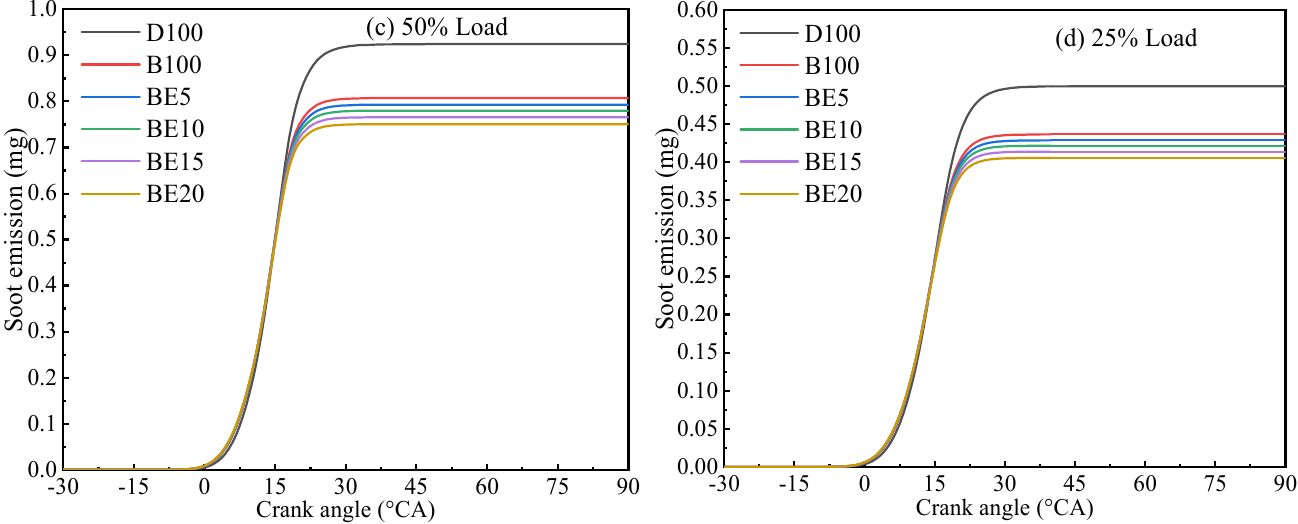
Figure 16. Comparison of soot emission for different blended fuels at different loads. ( a ) 100% Load, ( b ) 75% Load, ( c ) 50% Load, ( d ) 25% Load.